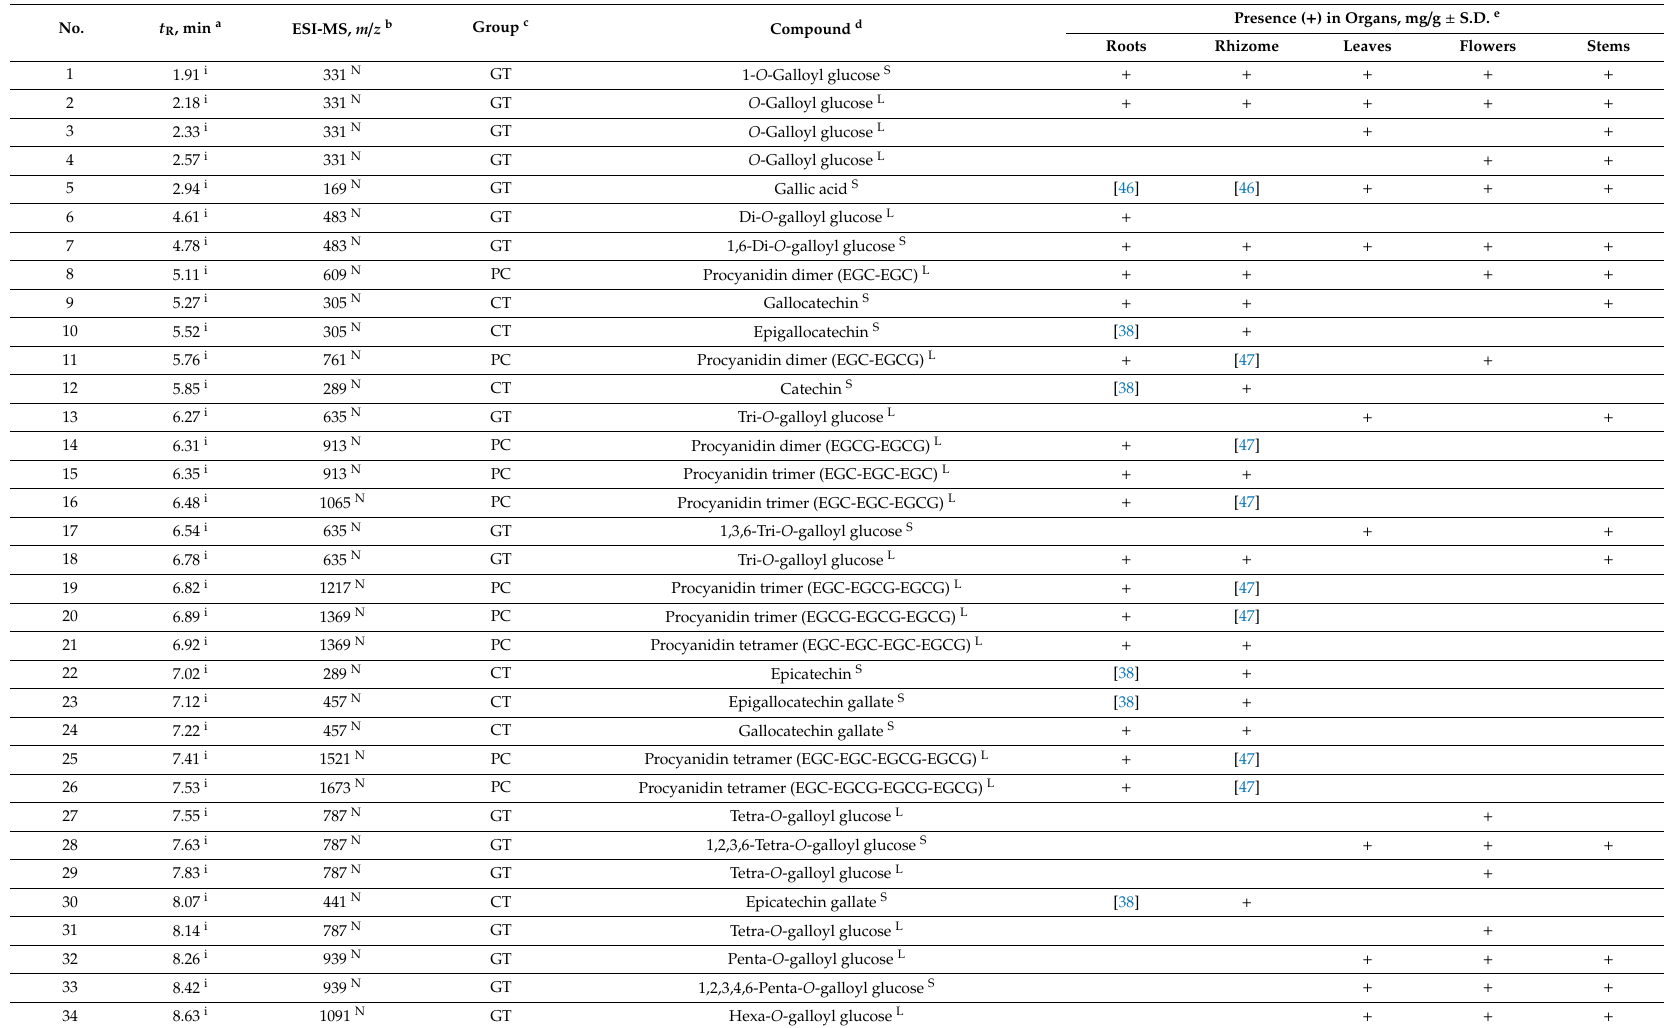
Table 5. Chromatographic ( t R ), mass-spectrometric data (ESI-MS) and presence in organs of compounds 1 – 146 found in R. rosea